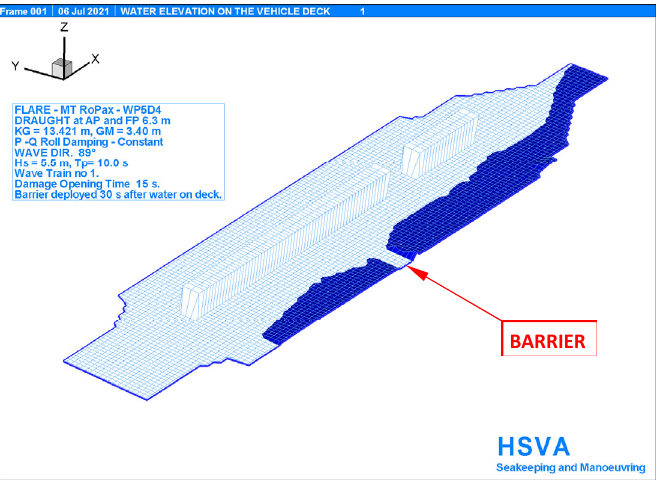
Figure 18. Water on the trailer deck on both sides of the closed barrier preventing further spreading of the floodwater.